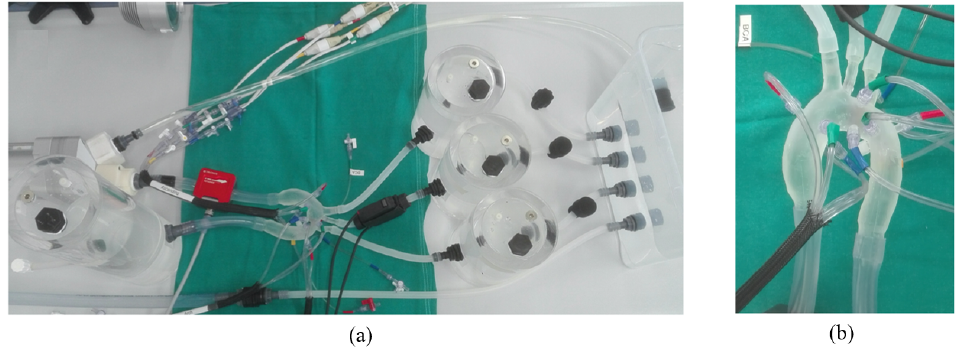
Figure 3. ( a ) Mock circulatory loop and ( b ) zoom of the healthy aorta